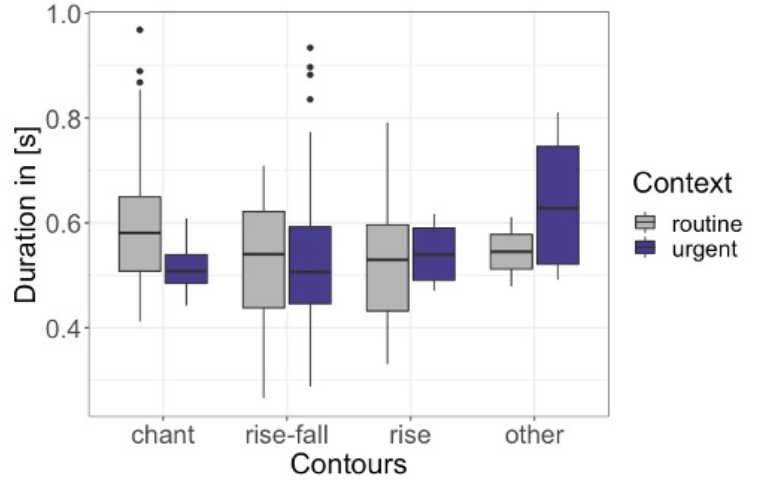
Figure 20. Word duration of one-syllabic words in the routine and urgent context across different calling melodies in